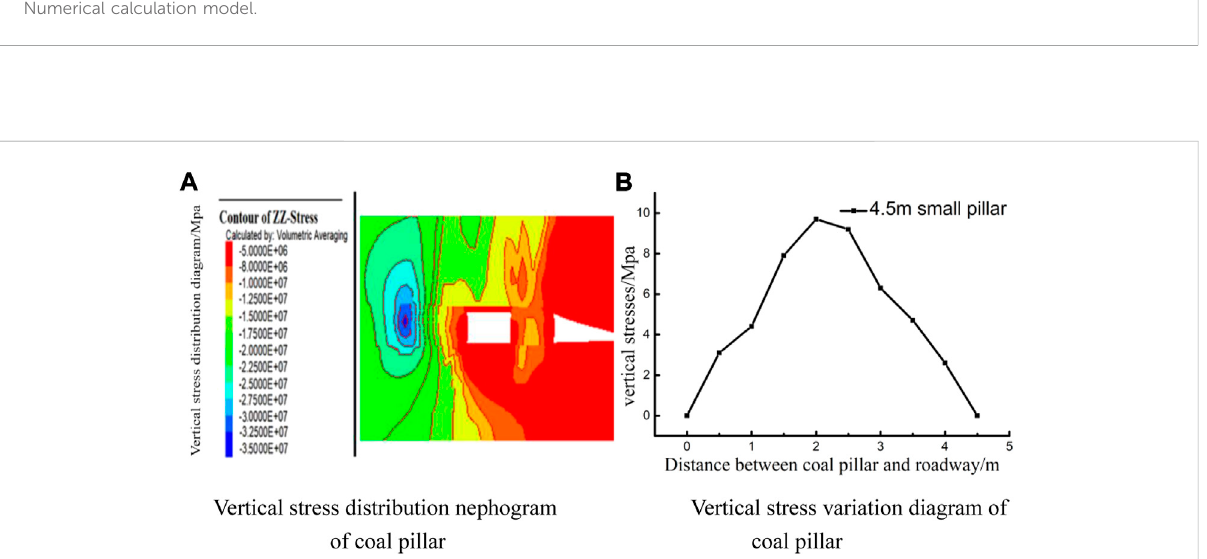
FIGURE 8 Coal pillar vertical stress distribution diagram. (A) Vertical stress distribution of the coal pillar. (B) Vertical stress variation diagram of the coal pillar.